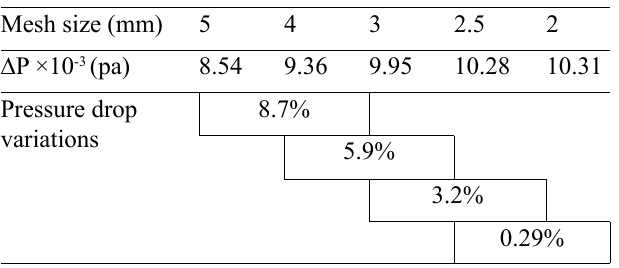
Table 5. Grid independence results for a packed bed with cylindrical particles in